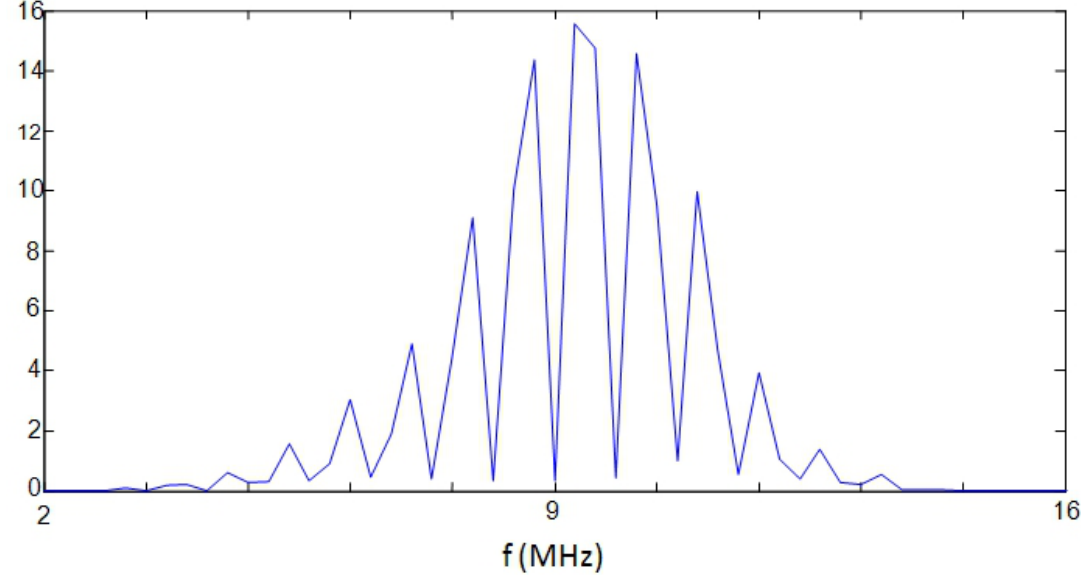
Figure 13. Periodogram of echoes coming from the same tube wall considered in Figures 11 and 12, which is related to the A-Scan number 26.